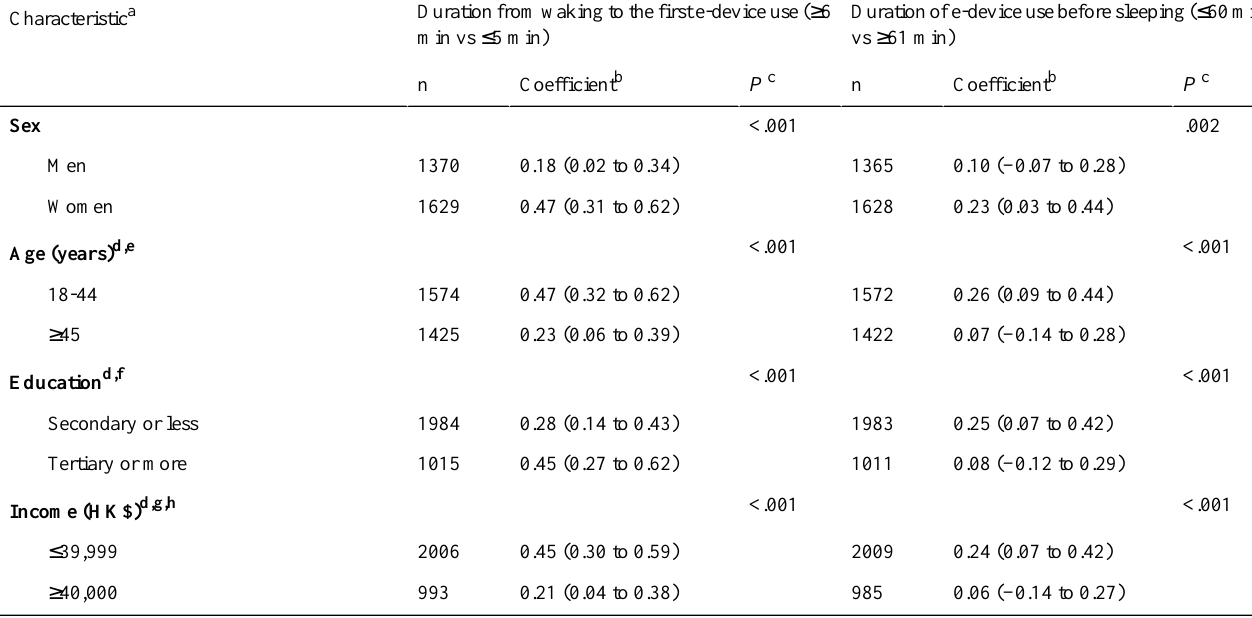
Table 6. Interaction effect between Hong Kong adults’demographics and e-device use for anxiety